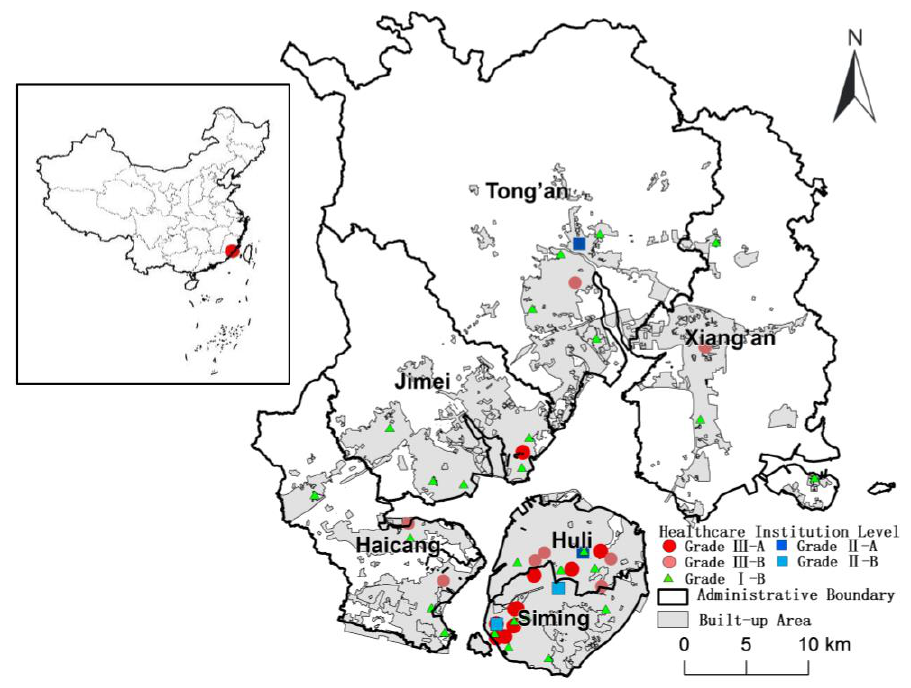
Figure 1. Spatial distribution of medical institutions in the six districts of Xiamen City.